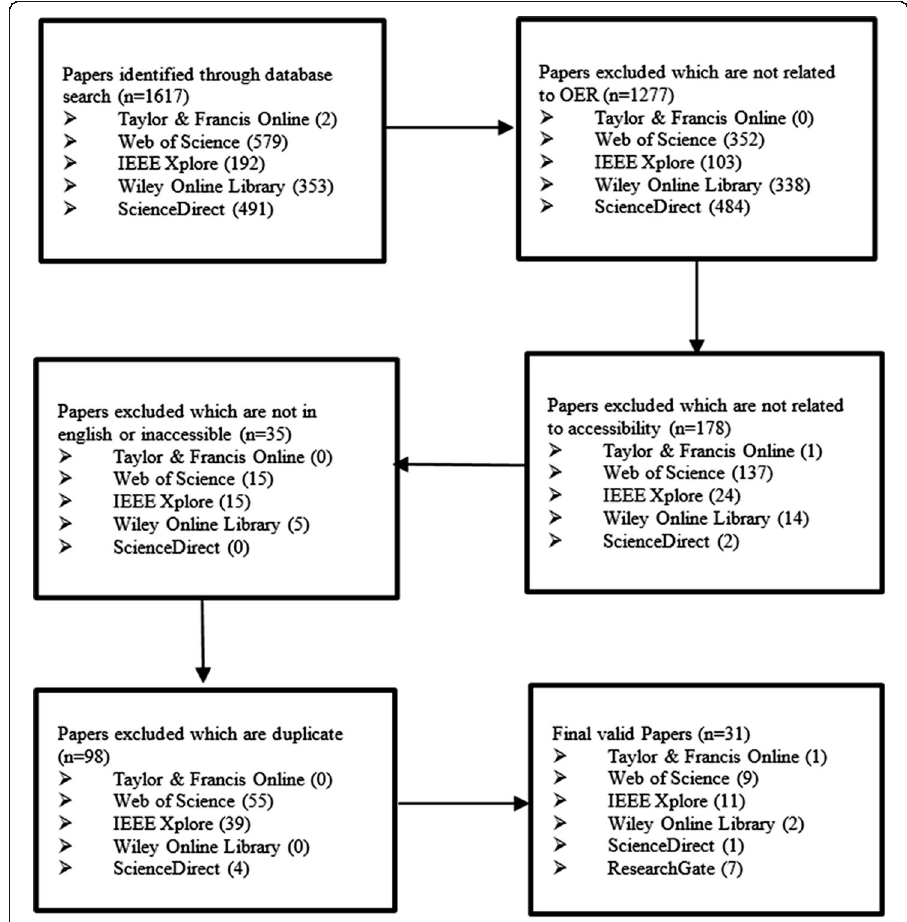
Fig. 1 Selection procedure of papers during the review process